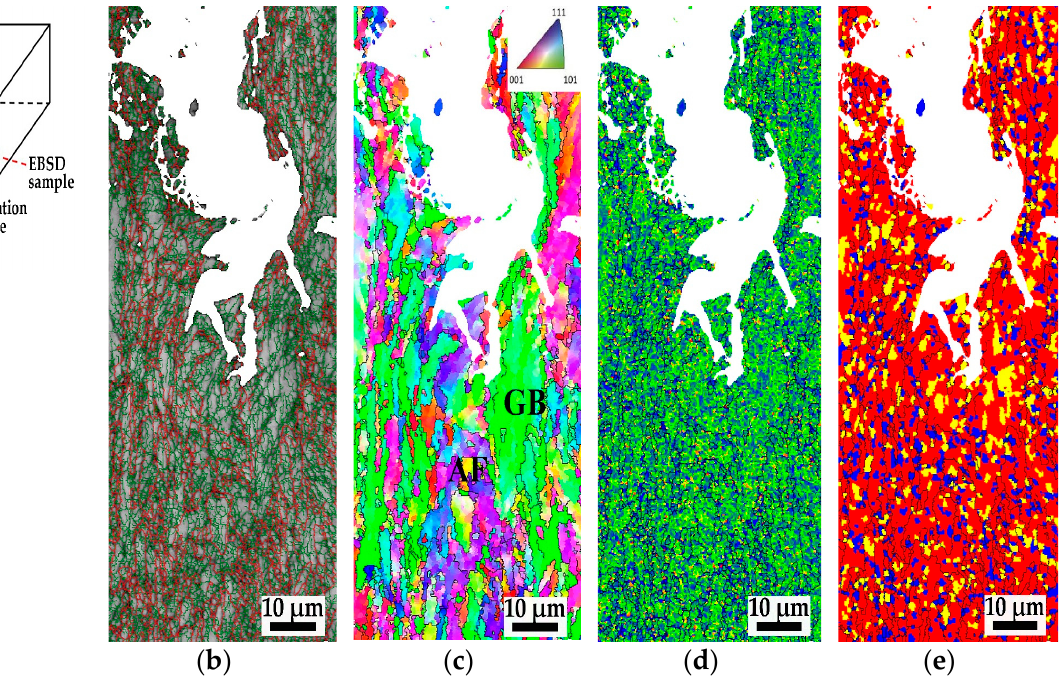
Figure 9. Schematic diagram of EBSD sampling location ( a ) and EBSD analysis diagrams with {001} plane around the tip of delamination crack; ( b ) image quality plus grain boundary misorientation map; ( c ) color-coded inverse pole figure plus grain boundary misorientation map (black line, >15°); ( d ) kernel average misorientation map; ( e ) distribution map of deformed grains, recrystallized grains and substructures.